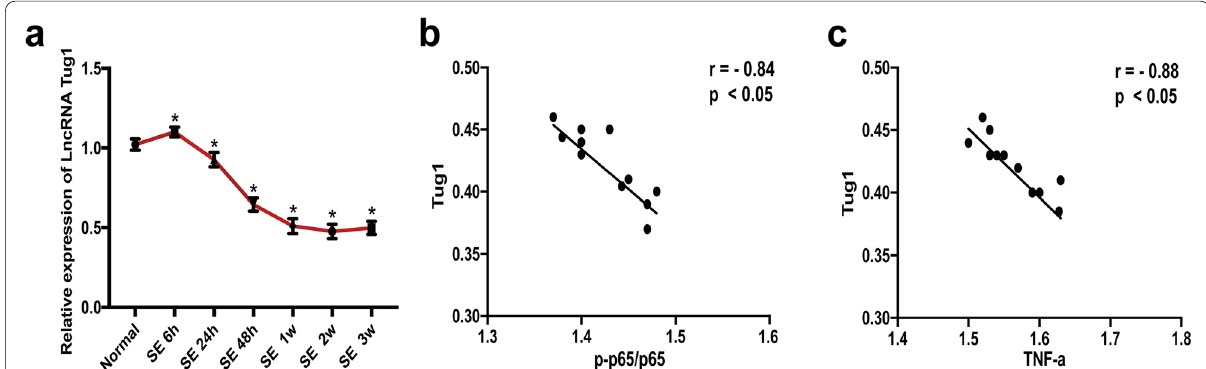
Fig. 2 Tug1 was downregulated in the hippocampus of SE rats. a The level of Tug1 in rat hippocampus after SE ( n analysis of Tug1 and p-p65/p65 in hippocampus of 2-week group. c Pearson correlation analysis of Tug1 and TNF-α mRNA in rat of SE 2-week